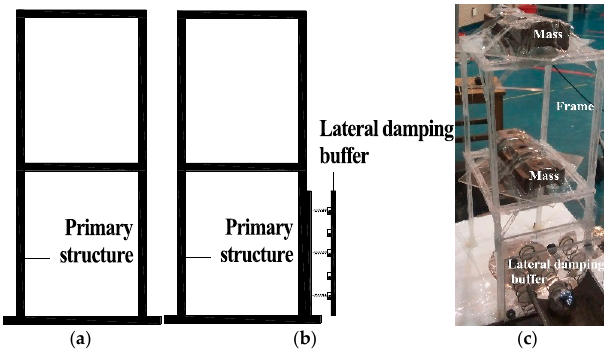
Figure 2. Schematic diagram of the test: ( a ) Uncontrolled structure; ( b ) Structure with the lateral damping buffer; ( c ) Experimental model picture.